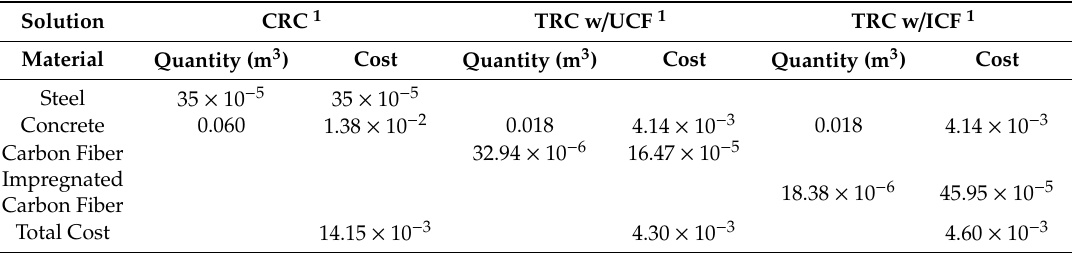
Table 6. Cost analysis.